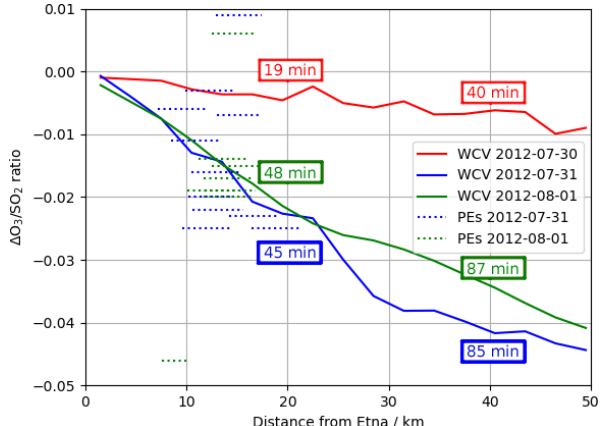
Figure 16. Modelled (cid:49) O 3 / SO 2 ratios at 08:00UTC on 30 July 2012, 1 August 2012, and 31 July 2012 (solid lines) and observed O 3 vs. SO 2 gradient from each of the major plume en- counters (dashed lines), plotted against distance from the volcano. Observations are plotted as horizontal lines spanning the range of distances from the volcano at the plume encounter. Annotations give the average age of the modelled plumes at 20 and 40km